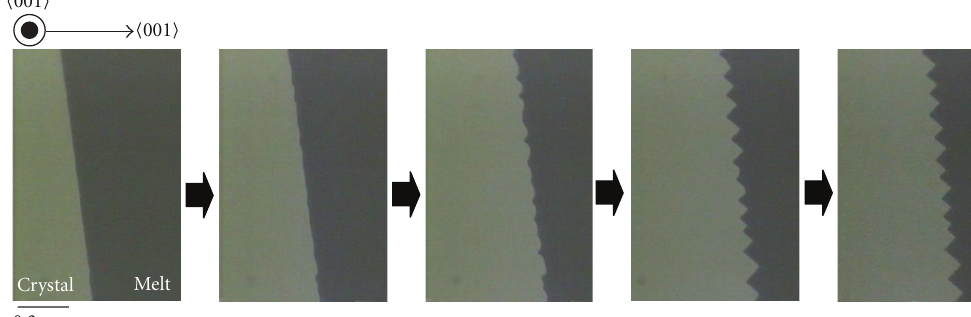
Figure 1: Morphological transformation of Si (100) crystal-melt interface moving at 162 μ m/s